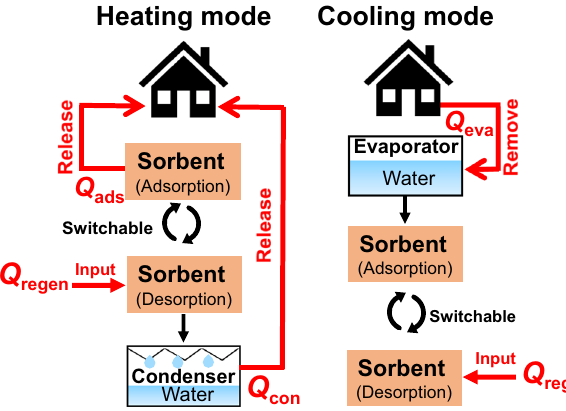
Fig. 5 Heat transfer between the sorbent and the working fl uid water for heating and cooling. In the heating mode, the sorbents LiCl@HGAFs capture water molecules and release adsorption heat ( Q ads ) to the house for indoor heating. As the adsorbent will become saturated with water, regeneration is required. Energy is taken up at a relatively high temperature ( Q regen ) to desorb the water, which is subsequently condensed, releasing heat at an intermediate temperature ( Q con ) to the house. Both of the released Q ads and Q con contribute to indoor heating. In the cooling mode, heat is taken up from the house by the evaporation of the working fl uid ( Q eva ), driven by the water sorption of the sorbents LiCl@HGAFs. Therefore, one can operate such a switchable sorption cycle as a heat pump to produce heating using Q con and Q ads , or to produce cooling by using Q eva